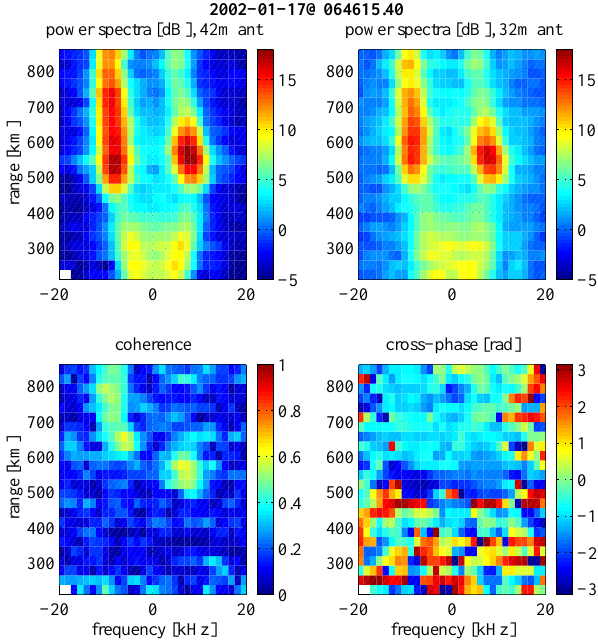
Fig. 13. Incoherent scatter measurements from the EISCAT Sval- bard radar using both the field-aligned dish and steerable dish can be used interferometrically to constrain the scale sizes of some types of plasma processes. In this example, naturally occurring ion-acoustic line enhancements are constrained to scale sizes of less than 500m in the horizontal dimension at the observed